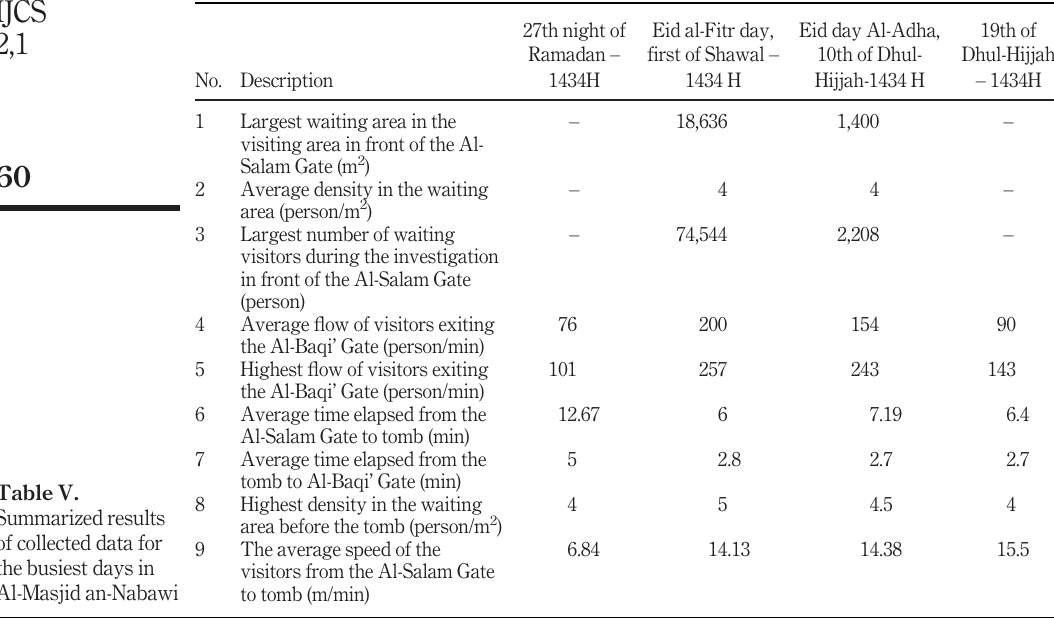
of collected data for the busiest days in Al-Masjid Pairs of the collected data sets representing the busiest periods of Hajj and Ramadan seasons for the time spent by visitors from the visiting area till the exit gate were subjected to t -test and F -test